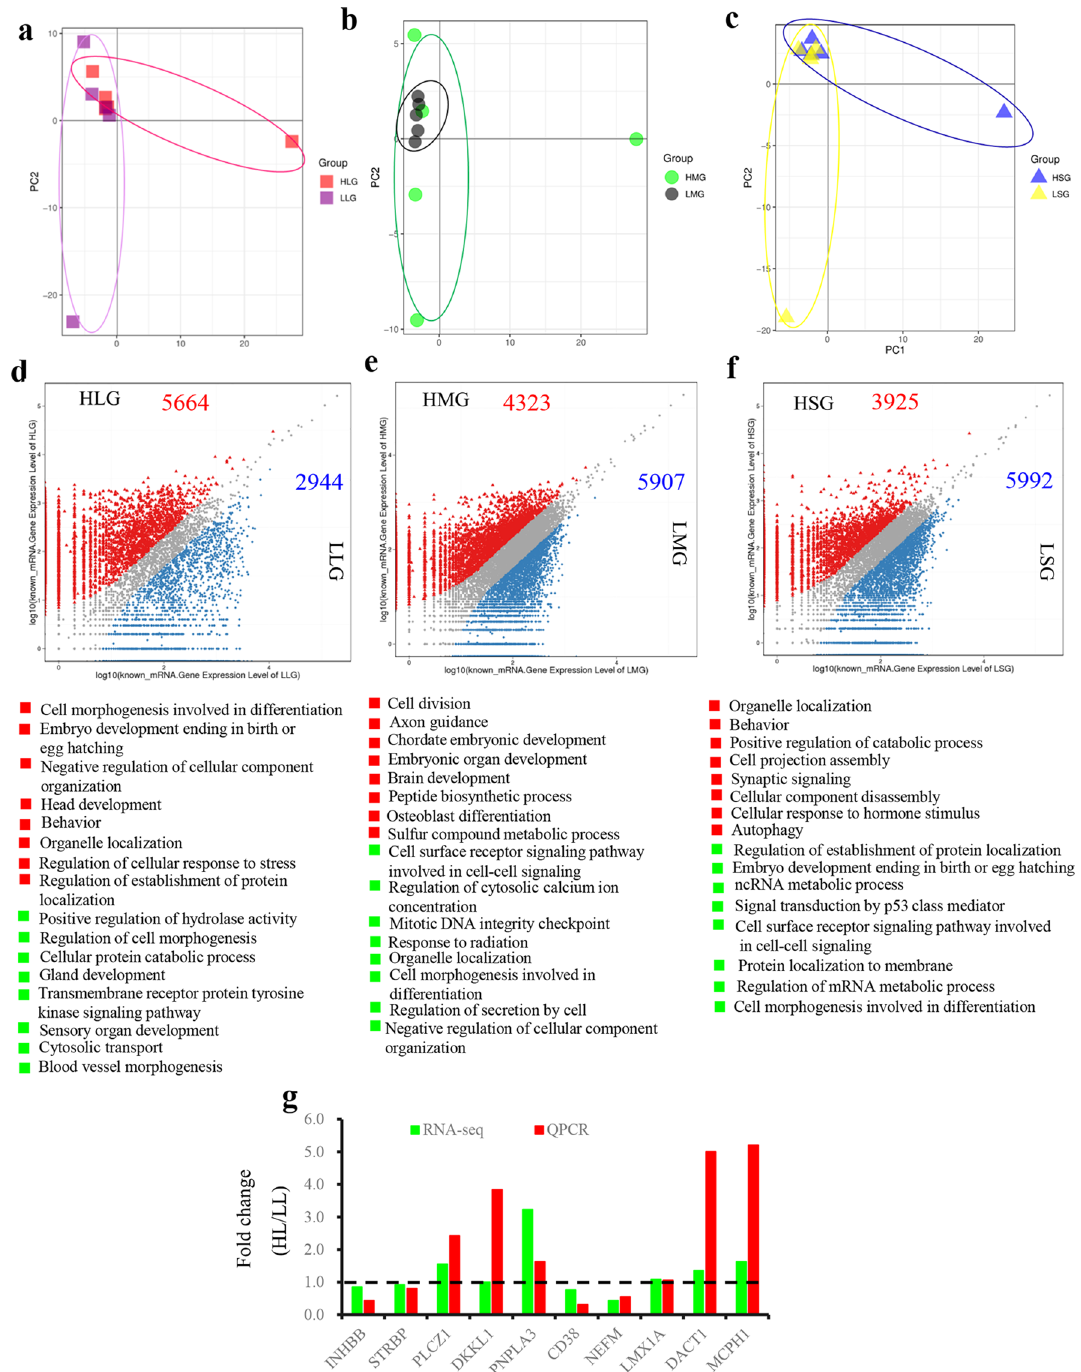
Figure 4. Dynamic gene expression in GCs of different fertility groups throughout folliculogenesis. ( a ) PCA of GCs in large follicles of high fertility and low fertility samples (HLG vs. LLG). ( b ) PCA of GCs in medium follicles of high fertility and low fertility (HMG vs. LMG). ( c ) PCA of GCs in small follicles of high fertility and low fertility (HSG vs. LSG). ( d ) Differentially expressed genes (DEGs) in GCs of large follicles from high fertility group and low fertility group, and the top enriched function pathways. Red indicates the gene expressed higher in HLG; green indicate the gene expressed higher in LLG. ( e ) Differentially expressed genes (DEGs) in GCs of medium follicles from high fertility group and low fertility group, and the top enriched function pathways. Red indicates the gene expressed higher in HMG; green indicate the gene expressed higher in LMG. ( f ) Differentially expressed genes (DEGs) in GCs of small follicles from high fertility group and low fertility group, and the top enriched function pathways. Red indicates the gene expressed higher in HSG; green indicate the gene expressed higher in LSG. ( g ) The comparation of RNA-seq data and PCR data for GCs. Fold change of high fertility group compared to low fertility